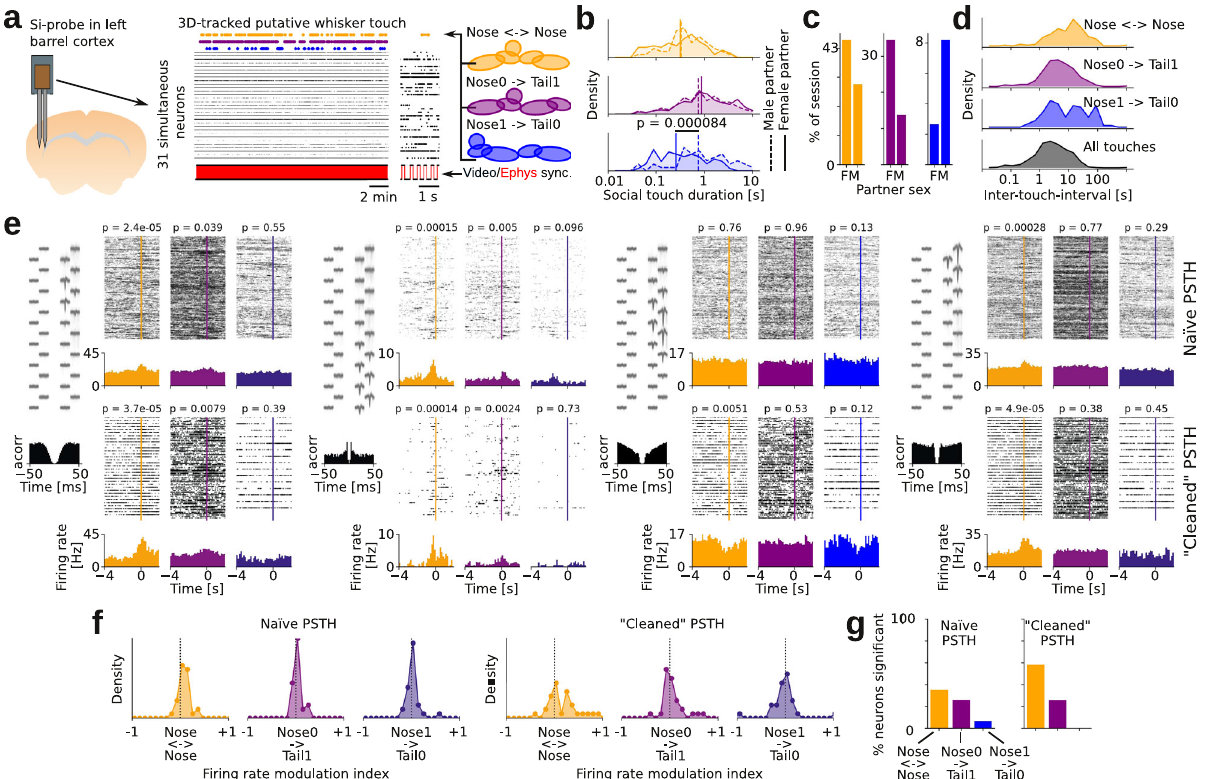
Fig. 6 Automatic measurement of fi ring rate modulations during social touch. a Automatically-detected social touch events in mouse implanted with silicon probe (Si-probe) with 31 single-units from barrel cortex during a single 20 min behavioral session. Yellow, nose-to-nose; purple, implanted-nose-to- partner-tail; blue, partner-nose-to-implanted-tail. b Distribution of touch durations with male (dashed) and female (solid) partner ( p = 0.000084, N = 64/ 46 male/female, two-sided Mann – Whitney U-test). c Percentage of behavioral session classi fi ed as social touch events, by partner sex, for two behavioral sessions. d Distribution of inter-touch-intervals for the two example behavioral sessions. e Social touch PSTHs for four neurons. For each neuron, the top row shows ‘ naïve ’ PSTHs (aligned to social touch event) and the bottom row shows ‘ cleaned ’ PSTHs (we only include events where no other social touch event occurred in the − 4 to 0 s period before the detected social touch). The PSTHs in the bottom row have fewer trials, but show much larger effect sizes. ( p -values indicate paired, two-tailed Wilcoxon signed rank tests, see “ Methods ” ) f , Percentage of neurons that pass a p < 0.05 signi fi cance criterion, based on the ‘ naïve ’ and ‘ cleaned ’ PSTHs shown above. g Distributions of effect size (measured as a fi ring rate modulation index), based on the ‘ naïve ’ and ‘ cleaned ’ PSTHs shown above. Source data and analysis scripts that generate the fi gures are available in the associated code/data fi les (see “ Methods ”